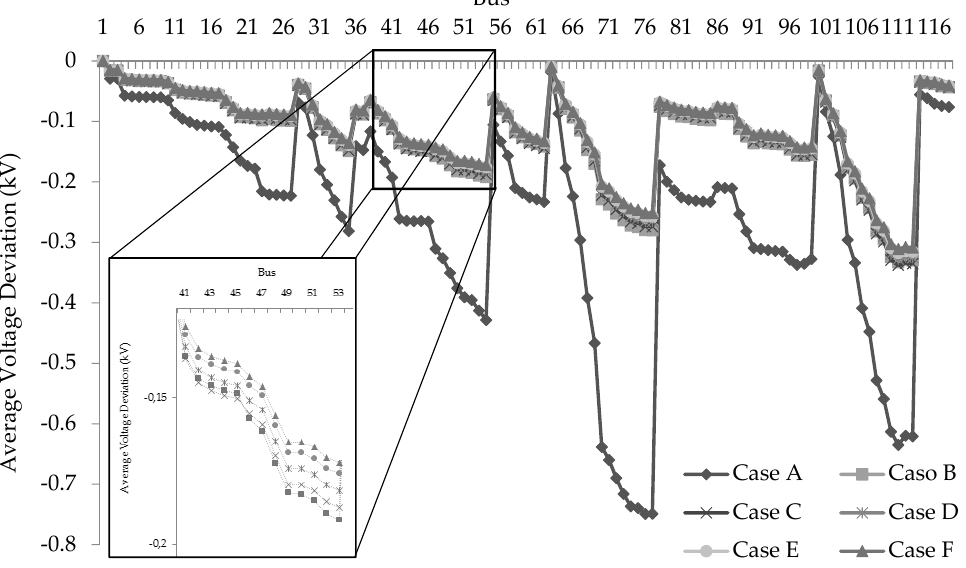
Figure 6. The average voltage deviation in all cases.